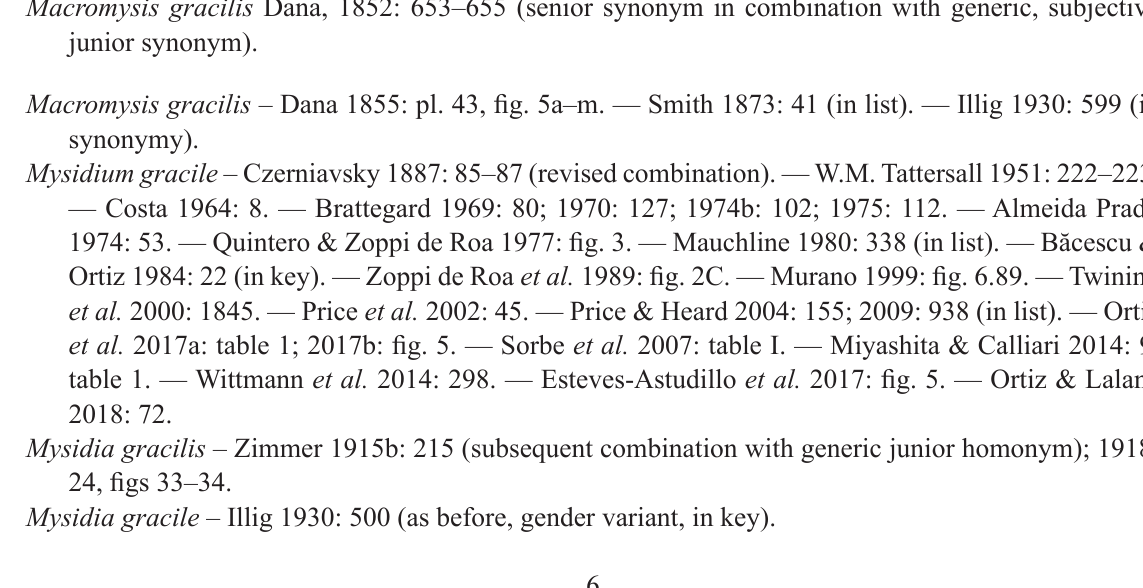
table 1. — Wittmann et al. 2014: 298. — Esteves-Astudillo et al. 2017: fig. 5. — Ortiz & Lalana 2018: